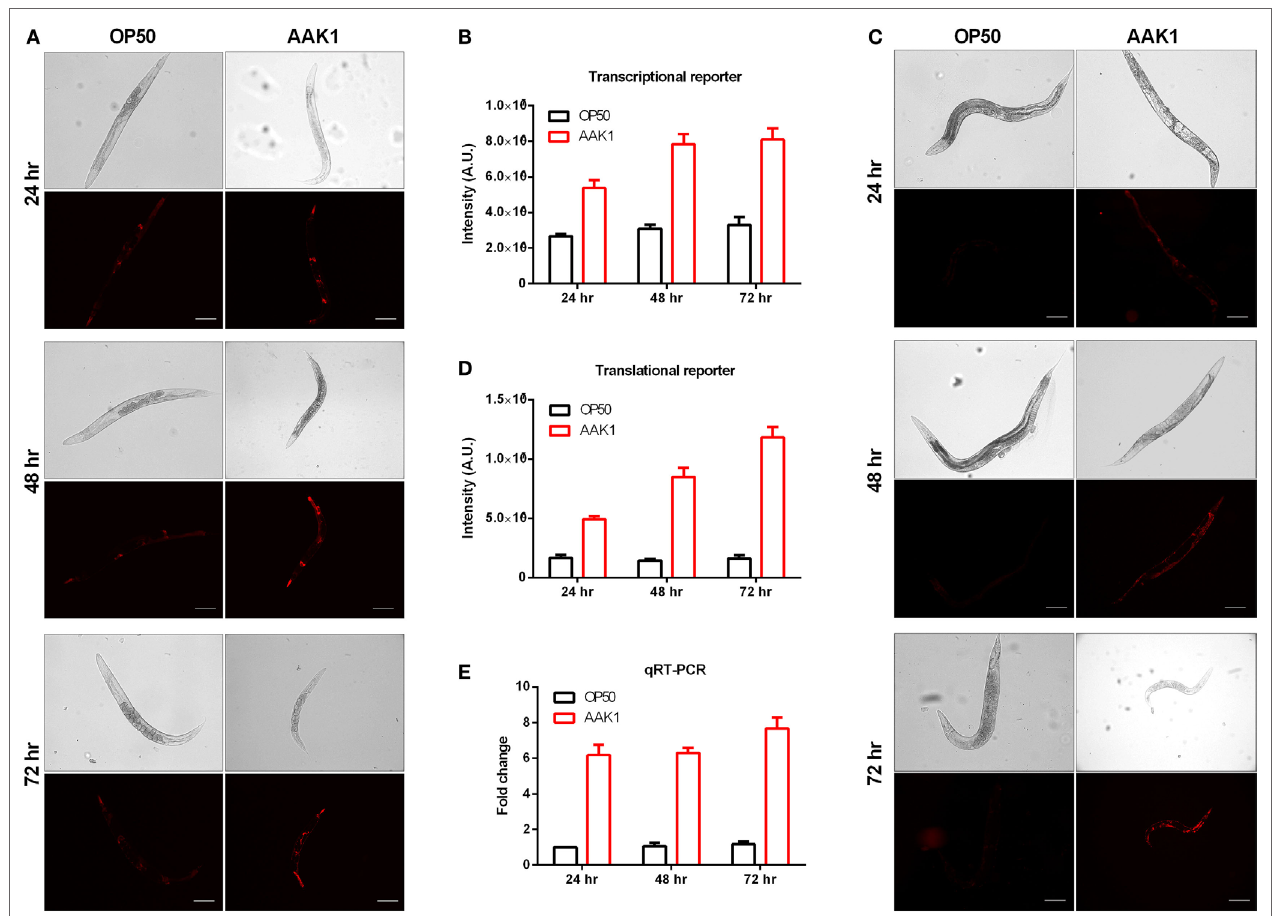
FigUre 2 | Expression level of riok-1 induced upon Aeromonas dhakensis infection. (a) riok-1 expression in the riok-1 transcriptional reporter strain ( riok- 1p:mCherry ) (B) Quantification of riok-1 expression in riok-1 transcriptional reporter worms. (c) riok-1 expression in the translational reporter strain (